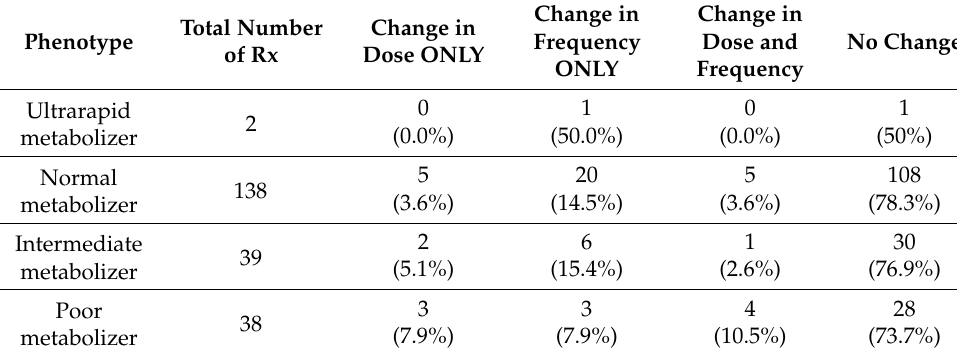
Table 4. Change in dose/dosing frequency in pain medication post-CYP2D6 pharmacogenomic testing, stratified by